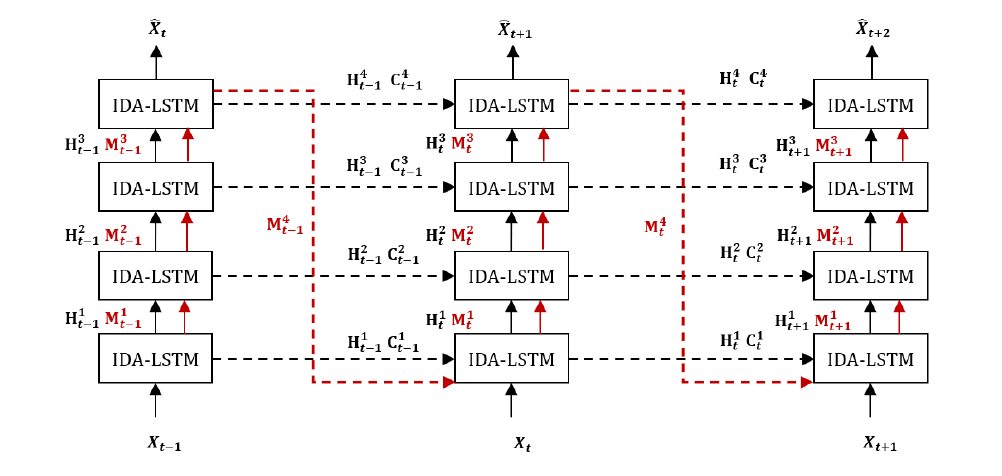
Figure 8. The architecture of our model.